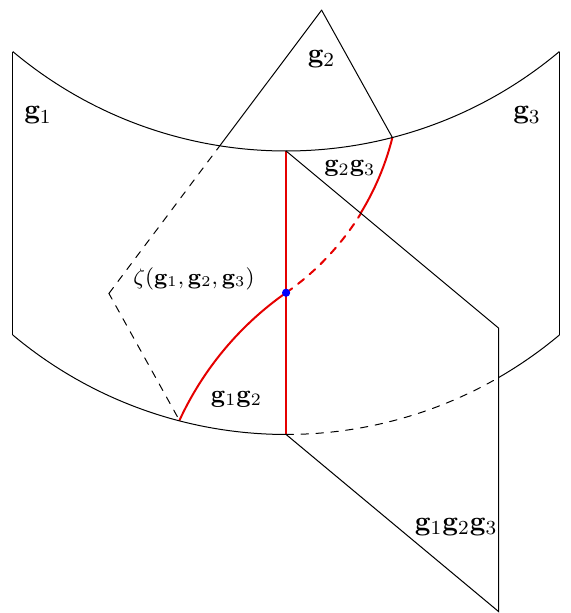
Figure 6 . A junction where four codimension-one 0-form symmetry defects of type g 1 , g 2 , g 3 , g 1 g 2 g 3 2 G meet in codimension three, with one additional dimension suppressed in the (cid:12)gure. The junctions of three codimension-one defects are in red, and their intersection is the blue point. The codimension-three intersection can be modi(cid:12)ed by inserting codimension-three symmetry defects of two-form symmetry (cid:23) ( g 1 ; g 2 ; g 3 ) 2 B . Note the four-junction considered here does not have addi- tional defects emanating from the codimension-three intersection, in contrast to the four-junction that described two-group symmetry discussed in [31]. In particular, a line operator encircling the upper-half of the junction produces the same phase as the line encircling the lower-half, since a line has trivial braiding with the codimension-three